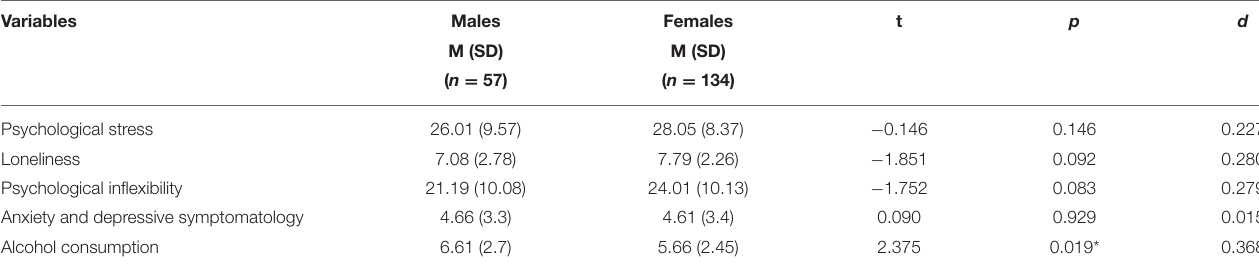
TABLE 2 | Gender differences in outcome